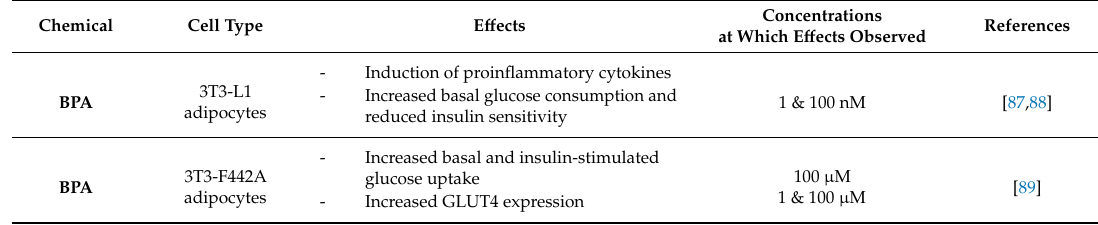
Table 2. E ff ects of MDCs on glucose consumption and insulin sensitivity in in vitro adipocyte models. Chemical Cell Type E ff ects